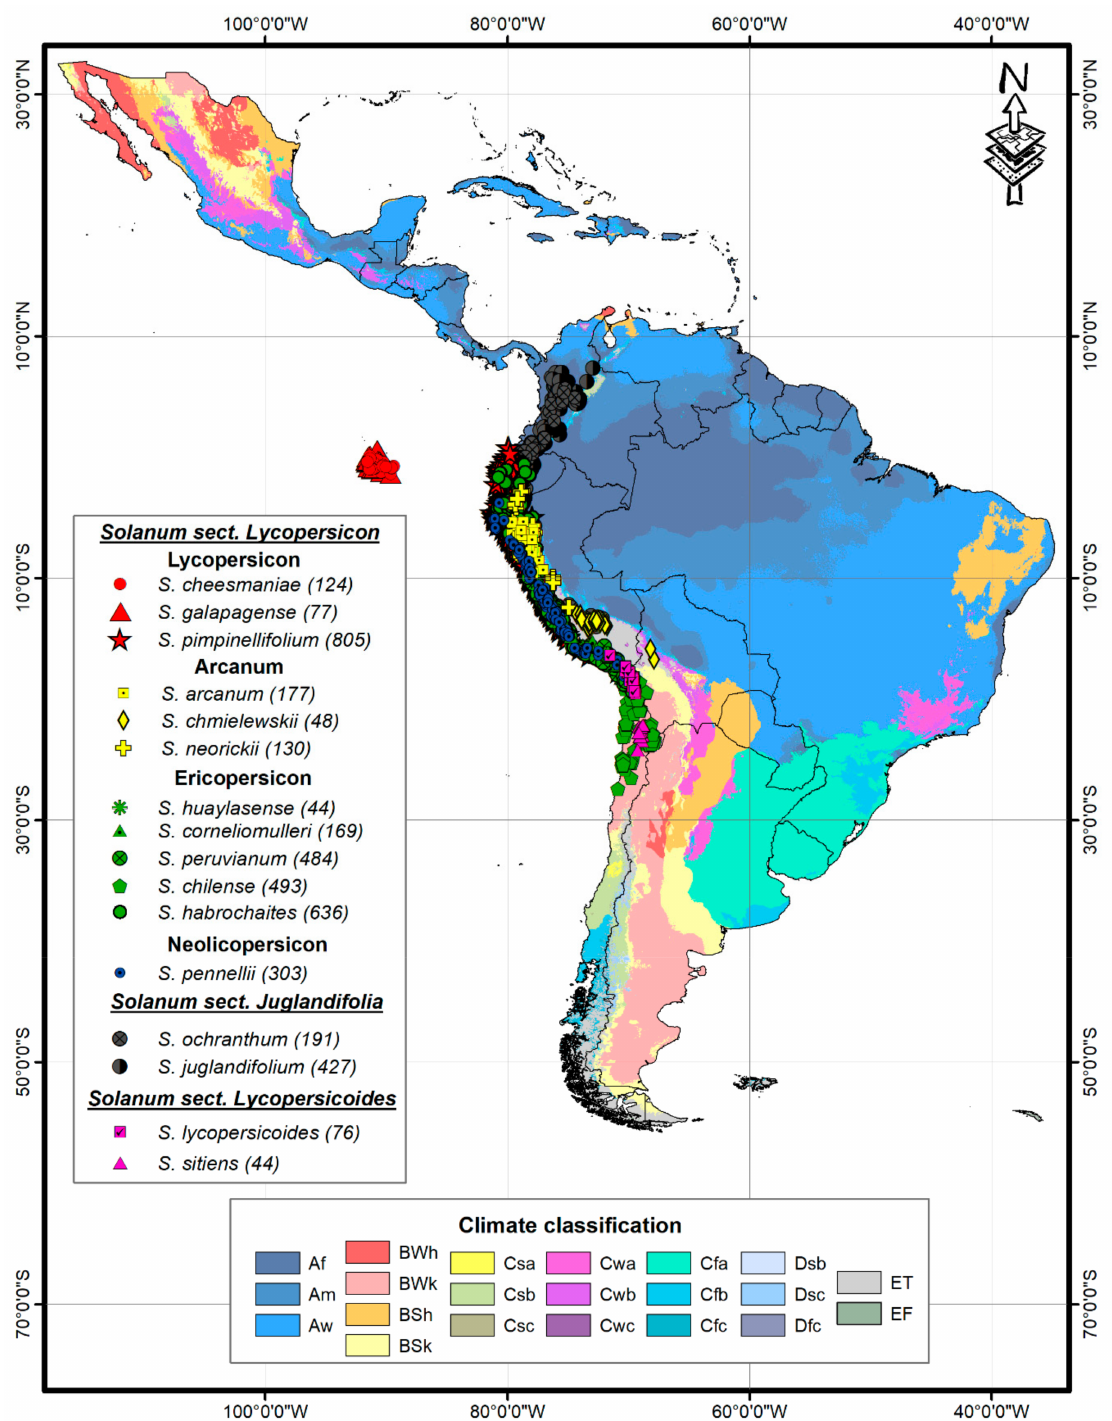
Figure 1. Climate classification according to Beck et al. [31] and geographic distribution of 12 wild tomatoes (Sect. Lycopersicon) and 4 closely related species (Sect. Juglandifolia and Lycopersicoides) Climate classification: Af (tropical, rainforest), Am (tropical, monsoon), Aw (tropical, savannah), BWh (arid, desert, hot), BWk (arid, desert, cold), BSh (arid, steppe, hot), BSk (arid, steppe, cold), Csb (temperate, dry summer, warm summer), Cwb (temperate, dry winter, warm summer), Cfb (temperate, no dry season, warm summer), and ET (polar, frost). In parentheses number of